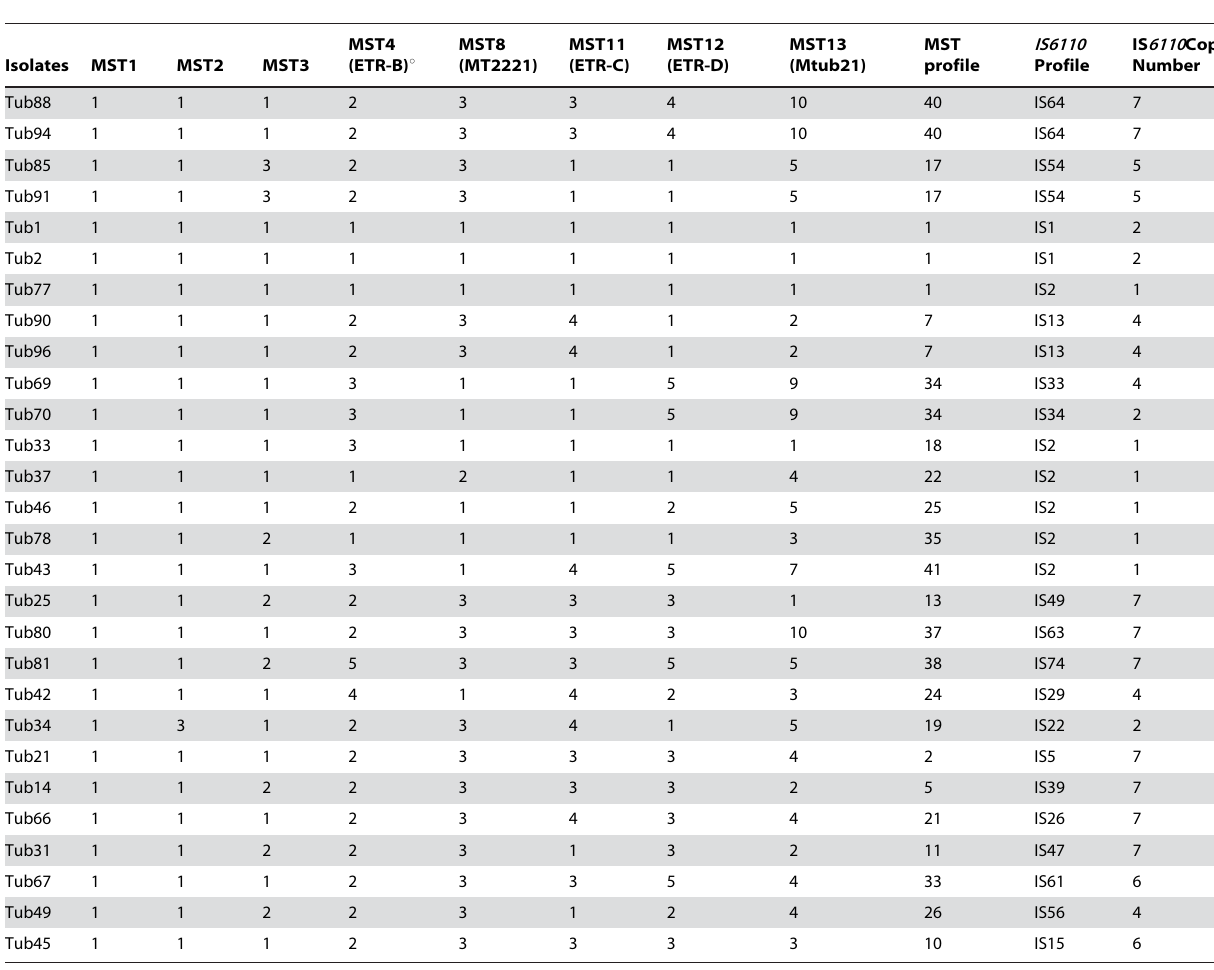
Table 4. MST analysis of 33 M. tuberculosis isolates exhibiting less than 8 IS 6110 copies.